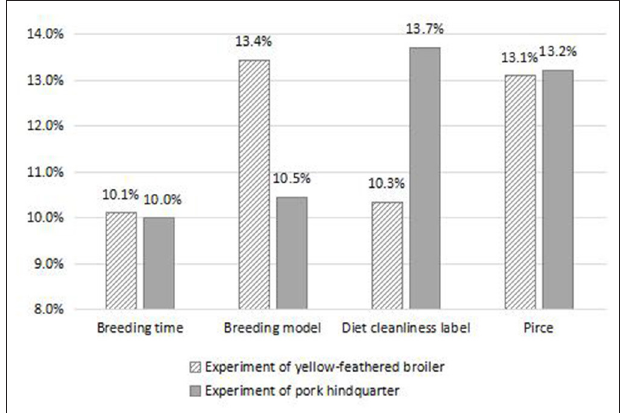
FIGURE 2 | 1 P of decoy under different attributes in the two